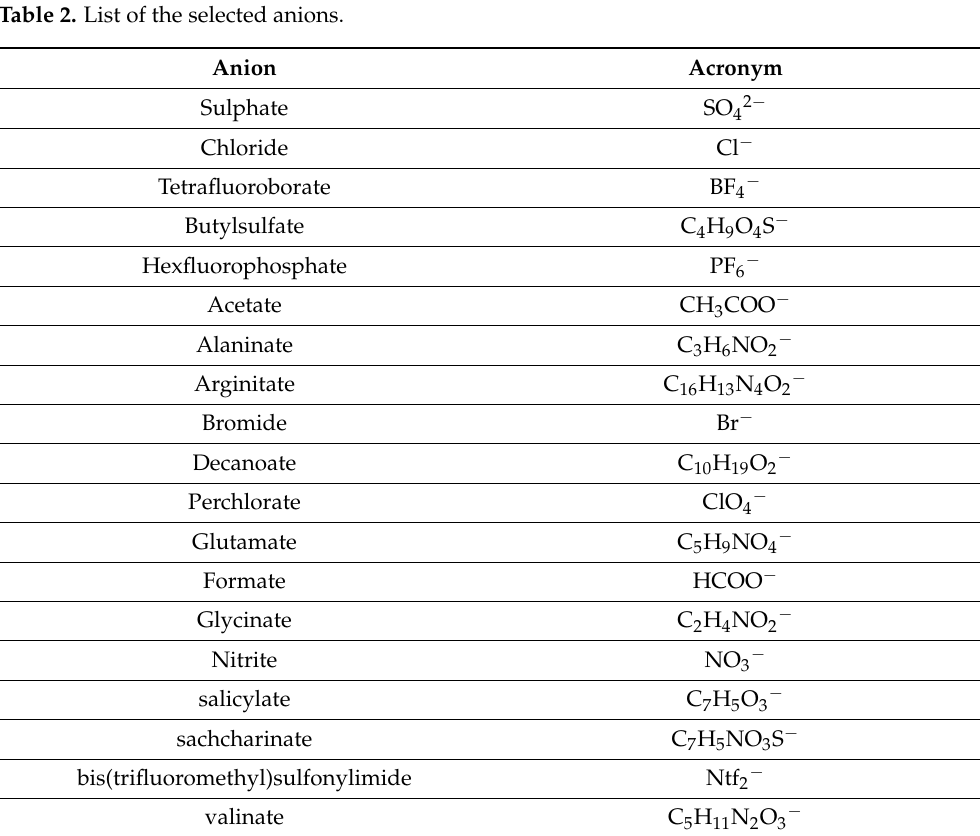
Table 2. List of the selected